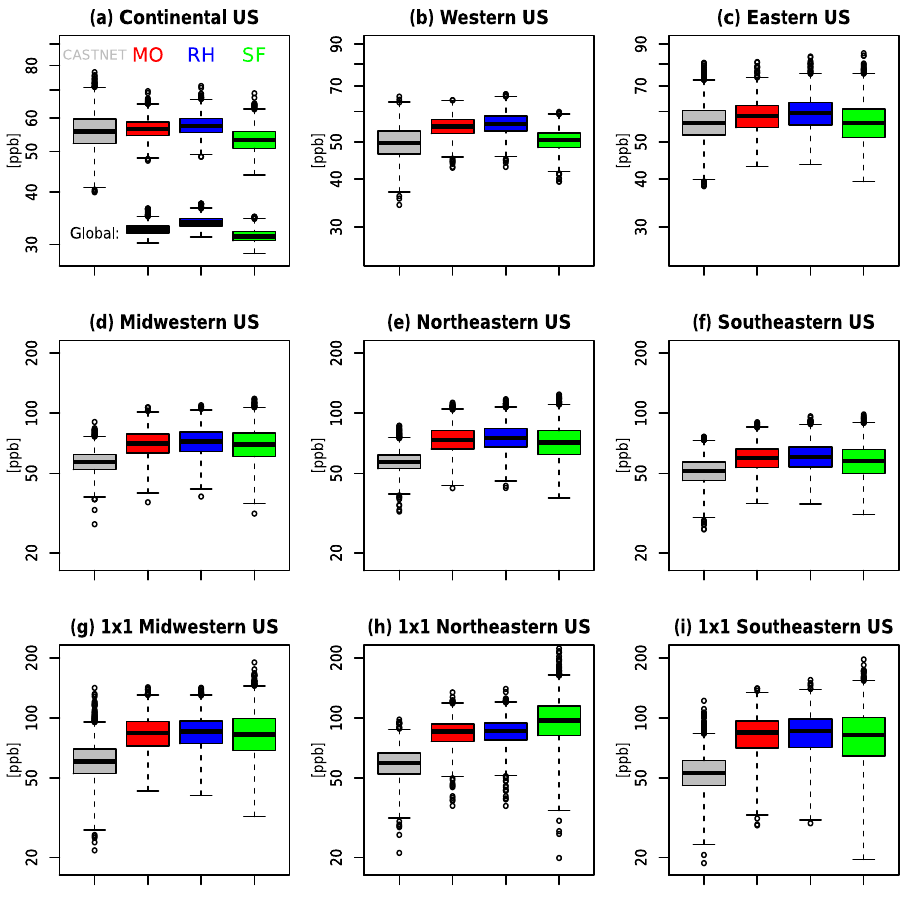
Figure 5. Surface JJA MDA8 O 3 boxplots for the 1991–2014 data for CASTNET (grey), MO (red), RH (blue), and SF (green) averaged over the various regions. Plots (g, h, i) are individual grid cells from within each region (38.8 ◦ N and 87.5 ◦ W for g , 38.8 ◦ N and 80.0 ◦ W for h , and 33.2 ◦ N and 85.0 ◦ W for i ). Global boxplots are included along with the continental US. The units are in ppb, and for each boxplot the box contains the interquartile range (IQR), the horizontal line within the box is the median, and the whiskers extend out to the farthest point which is within 1.5 times the IQR, with circles indicating any outliers. Note the scale difference between the top row and the rest of the panels.